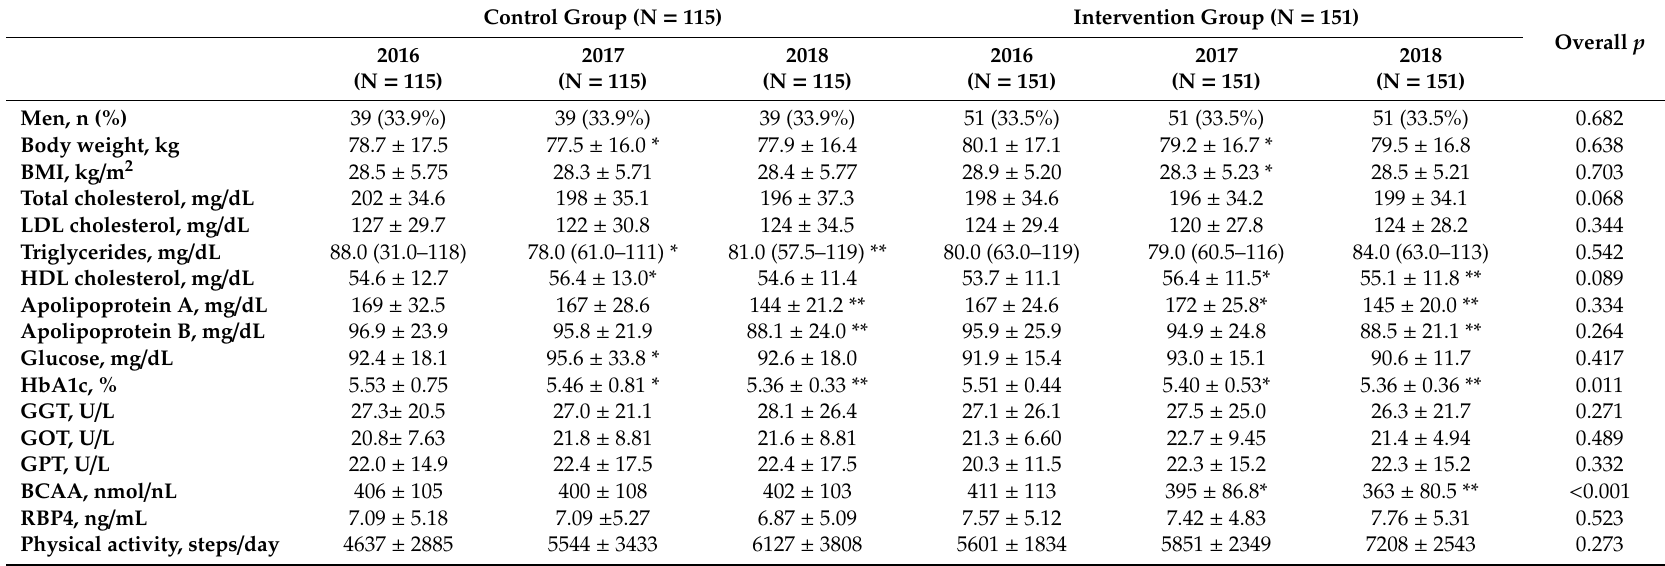
Table 3. Evolution of biochemical and anthropometric characteristics of all Spanish control and intervention subjects who have completed the Feel4Diabetes